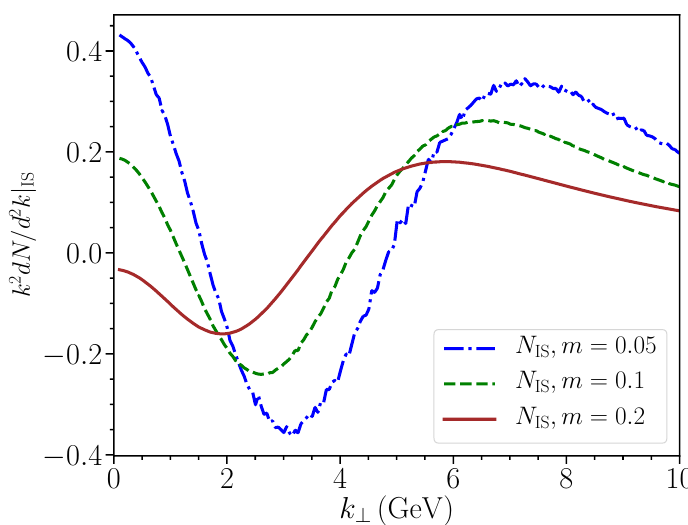
Figure 8. Within the first saturation corrections, the initial state interactions are sensitive to the infrared scale cutoff m